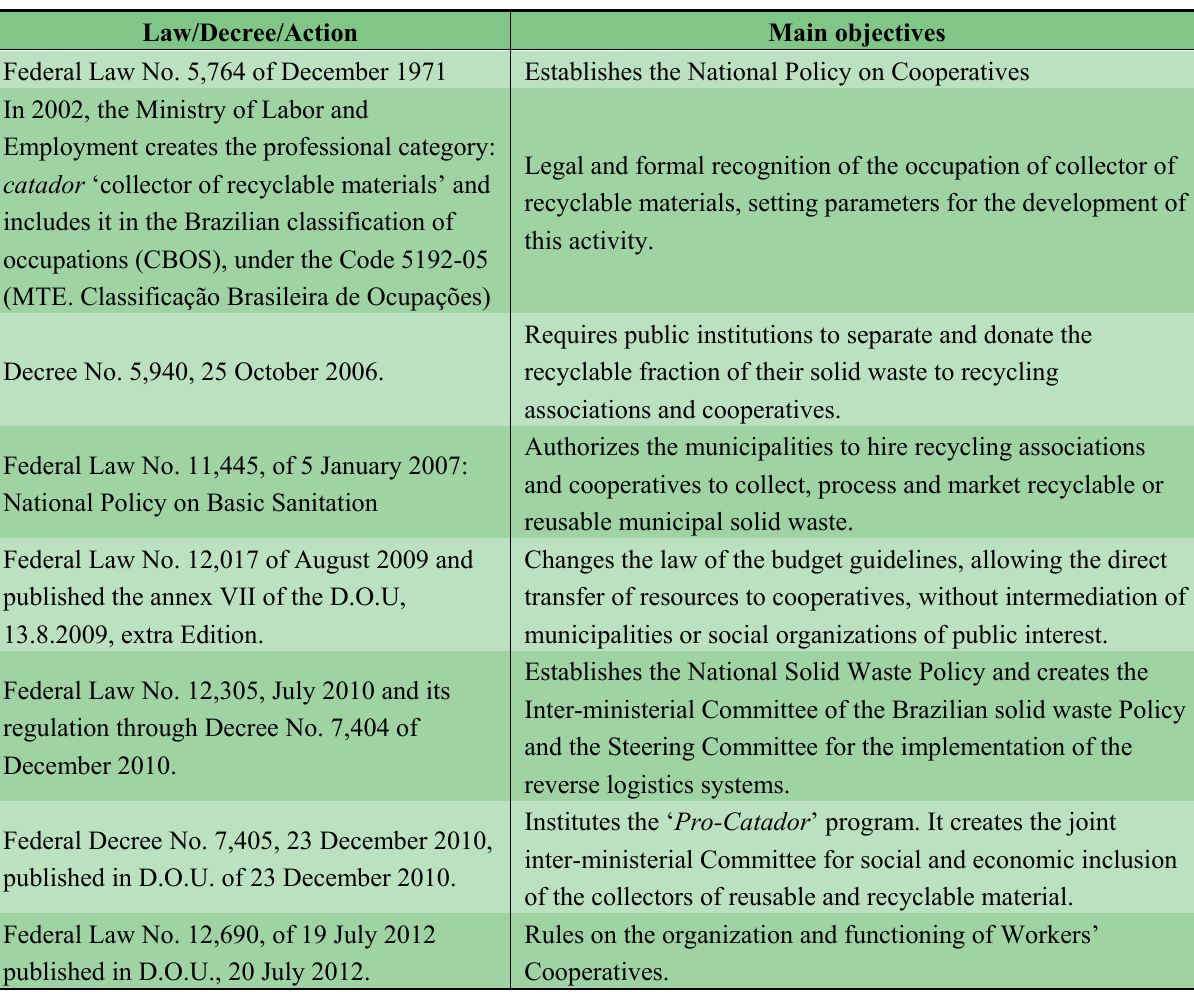
Table 2. Key legislation supporting the activity of informal and organized